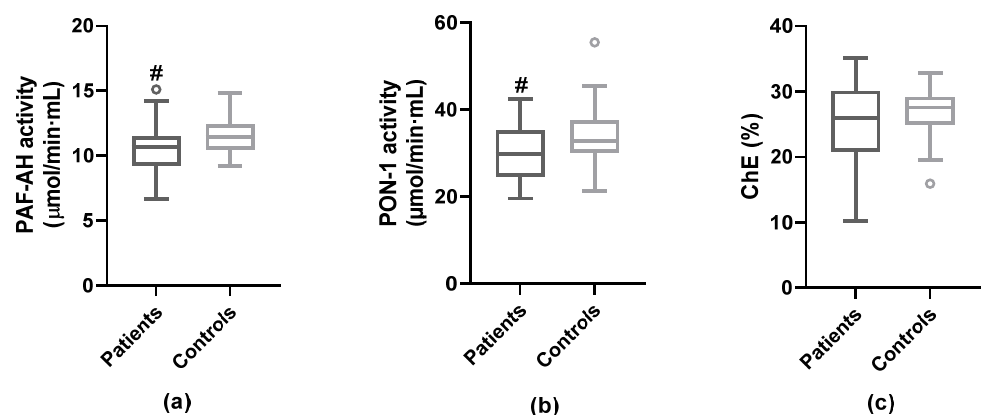
Figure 1. Parameters of HDL functionality. PAF-AH and PON-1 activities and ChE were quantified in apoB-depleted serum. PAF-AH and PON-1 activities were calculated from the slope of the enzymatic activity measured by colorimetric detection. ( a ) PAF-AH activity was determined by using 2-thio-PAF as a substrate. ( b ) PON-1 activity was measured using phenylacetate as a substrate. ( c ) ChE capacity of apoB-depleted serum was analyzed in THP1-CD14 macrophages after 24 h incubation. Patients